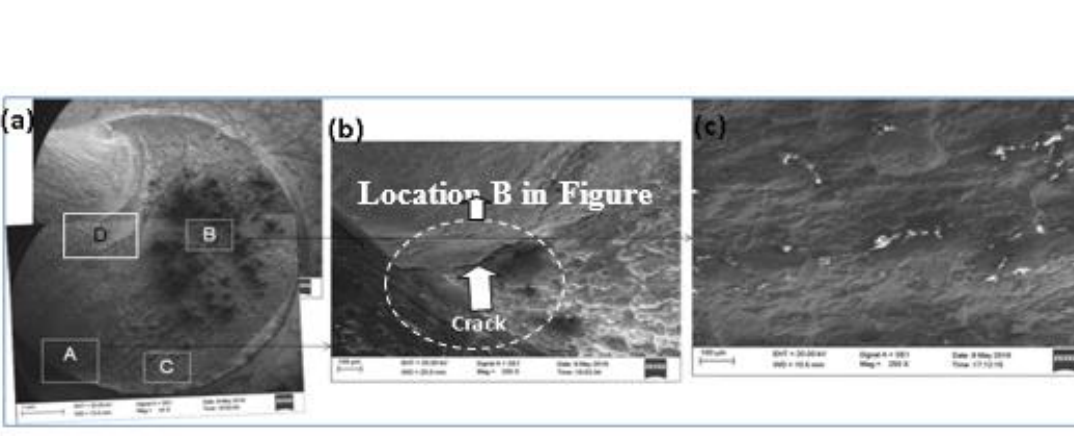
Fig. 5: SEM fractographs of failed bolt head in acetone cleaned condition.